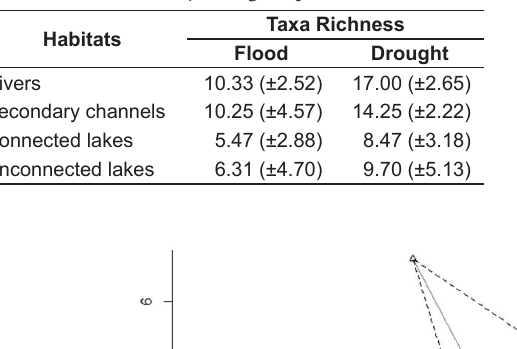
Table 1. Mean and standard deviation of taxa richness between habitats and hydrological